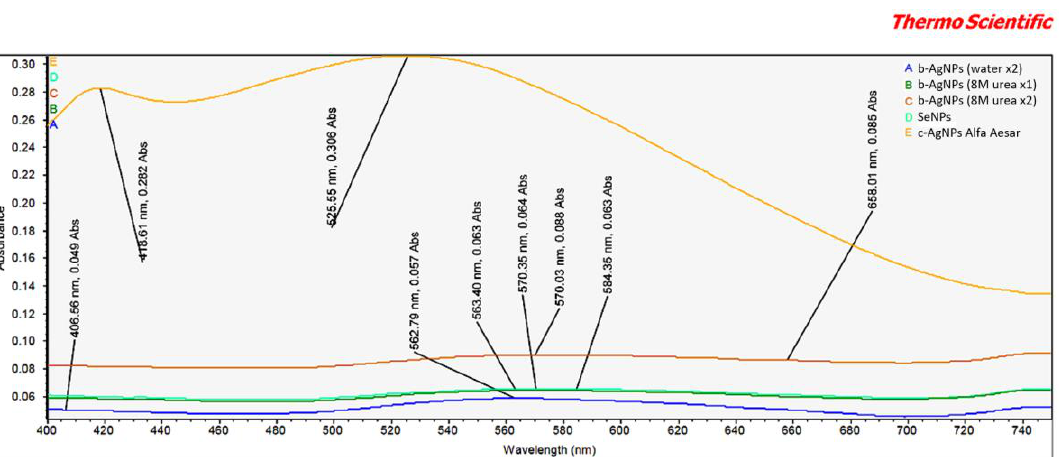
Figure 2. Visible Spectra of Tested Nanoparticles. Absorbance peaks are shown for all three b-AgNPs (A–C), Selenium NPs unrelated to current study (D) and Alfa Aesar c-AgNPs (E). FT-IR analysis of the b-AgNPs (8M urea × 2) and Alfa Aesar c-AgNPs samples demon- strated mostly similar absorbance patterns, with the exception of two small peaks seen for Alfa Aesar c-AgNPs at 2359.87 cm − 1 and 2336.46 cm − 1 wavelengths (Figure 3). Both peaks occurred in the mid-IR wavelength region. Two further differences noted were peaks at 667.86 cm − 1 for Alfa Aesar c-AgNPs and 507.55 cm − 1 for b-AgNPs (8M urea × 2). Neither appear to be in a frequency range associated with a characteristic functional